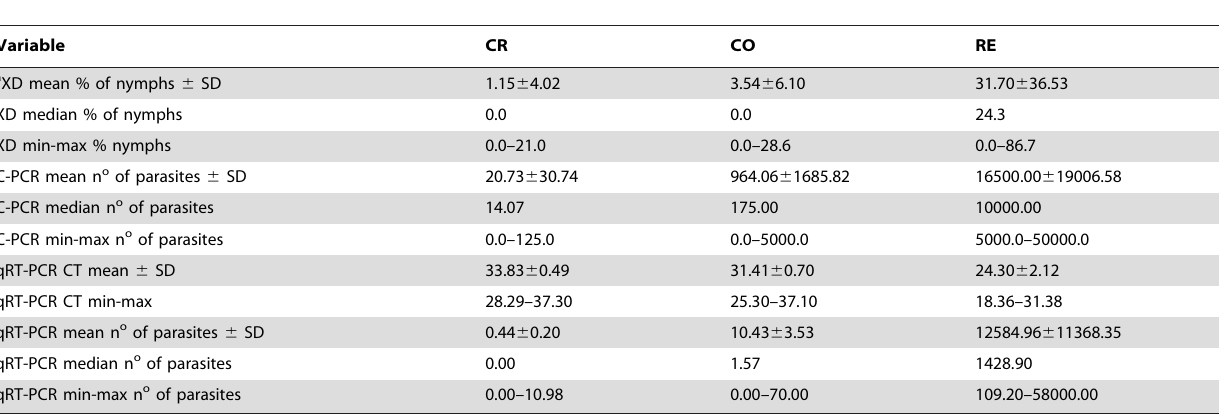
Table 2. Results of xenodiagnosis a , C-PCR b and qRT-PCR c in the three groups of patients d (CO, CR, RE).